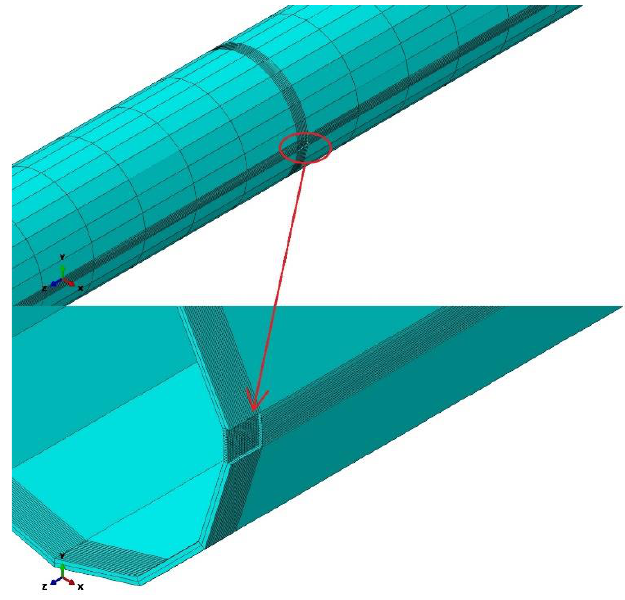
Figure 11. Corrosion defect pipeline model and grid diagram.